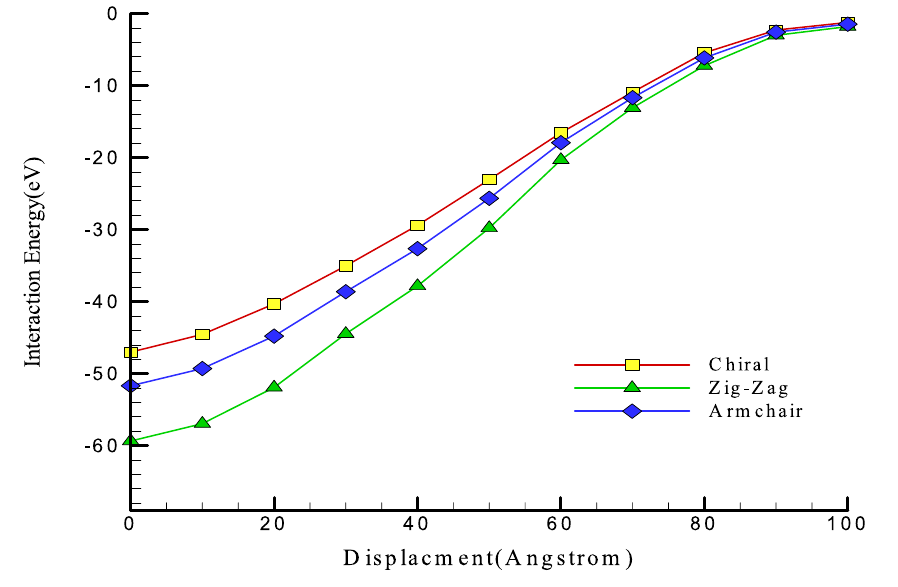
Figure 10. Interaction energy between various CNTs and a pristine matrix during the atomic pullout process.